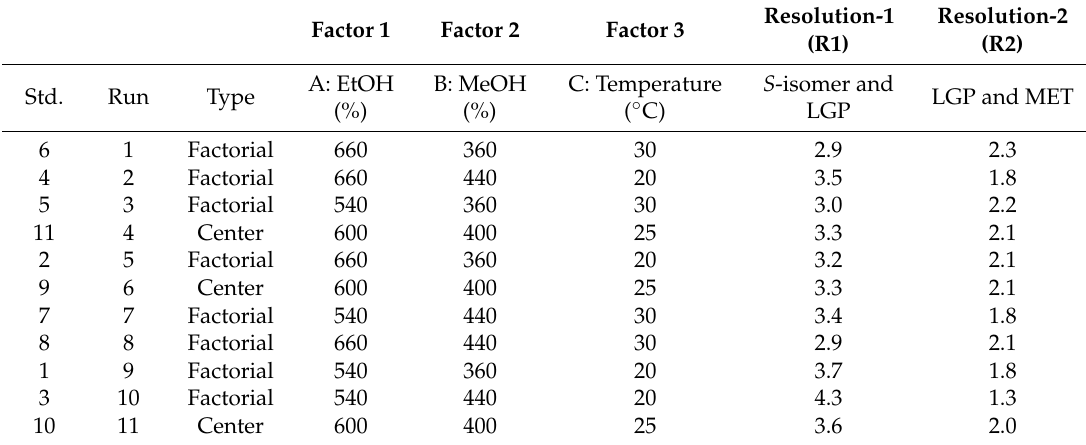
Table 2. Design of experiment (DoE) and results obtained by full factorial design.